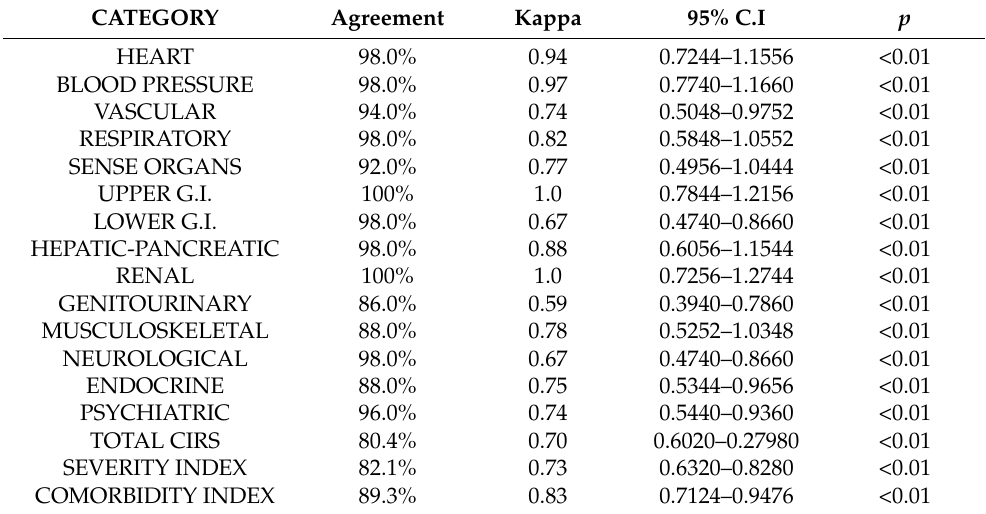
Table 4. Levels of agreement between the CIRS values reported by the pool of epidemiologists and ward doctors (fourth control).